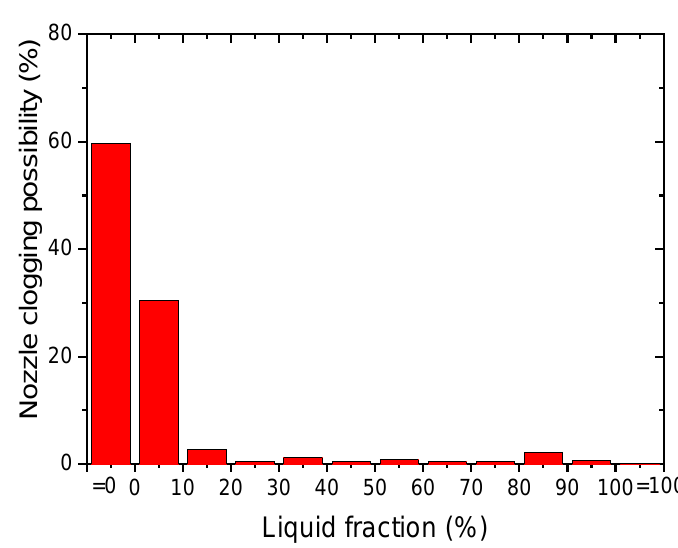
Figure 8. Frequency of the liquid fraction of clogging materials of the SEN and inclusions in the steel.